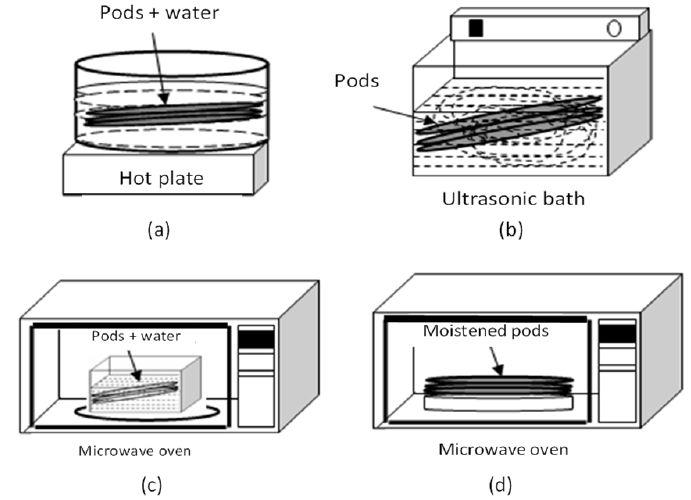
Figure 1. Equipment used during the “killing” stage of the CP: ( a ) water bath treatment (W), ( b ) ultrasound treatment with pods immersed in an ultrasonic bath with water (U1), ( c ) microwave treatment with pods immersed in a container with water (M1), ( d ) microwave treatment with moistened samples (M2).